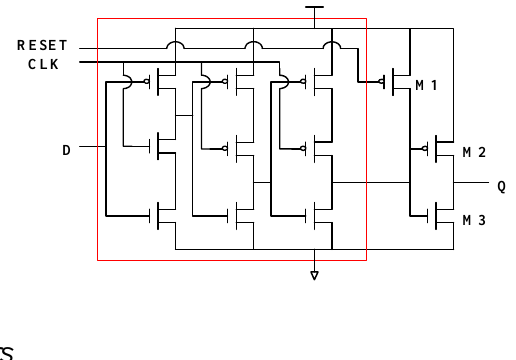
Figure 7. Modified DFF with three extra transistors, M1, M2 and